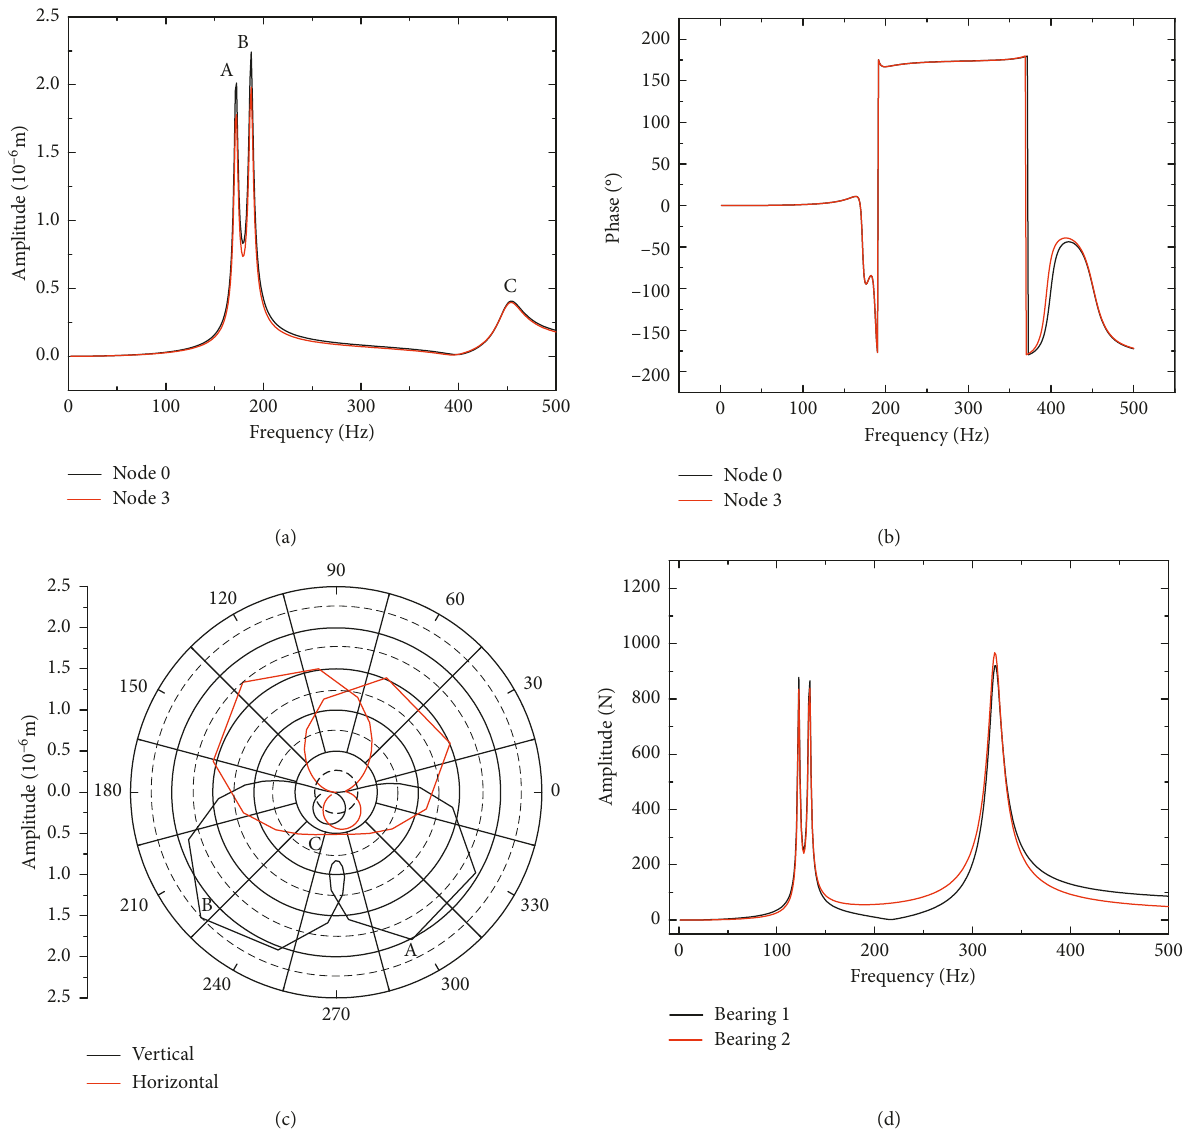
Figure 10: Rotor response and support reaction characteristics for Condition 2 (isotropic bearing stiffness). (a) Amplitude response at vertical direction. (b) Phase response at vertical direction. (c) Polar diagram at node 0. (d) Support reaction at vertical direction. Table 3: Resonance separation for the critical speed region. Bearing